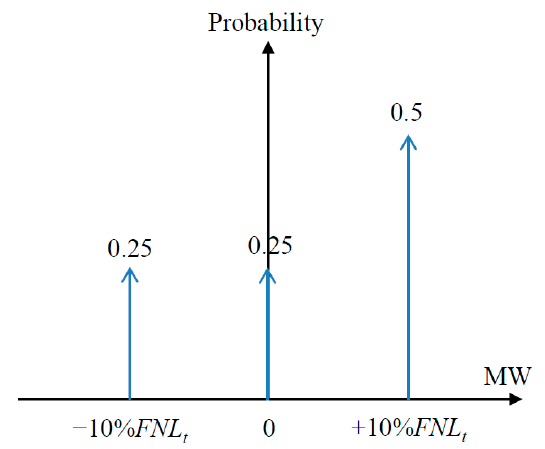
Figure 1. Probability distribution for E t.